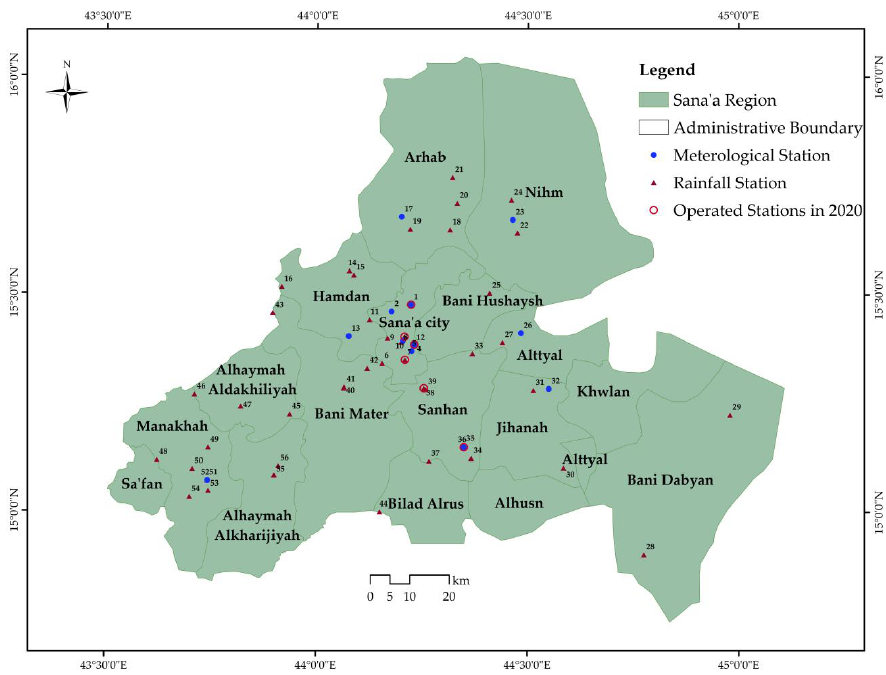
Figure 2. Meteorological and rainfall station distribution map in Sana’a